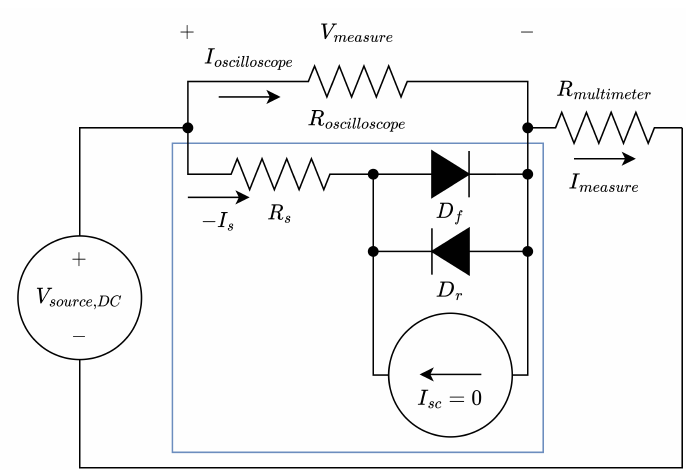
Figure 22. DC measurement setup. The area in blue represents an instance of the LSDCSM. Developed from